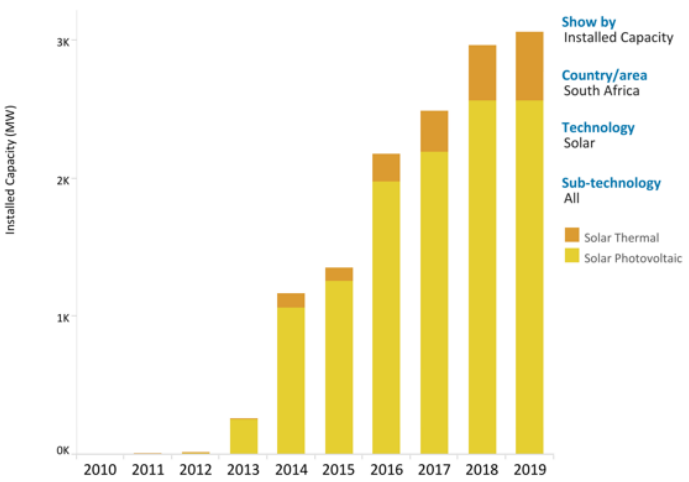
Figure 2. Solar capacity trends in South Africa